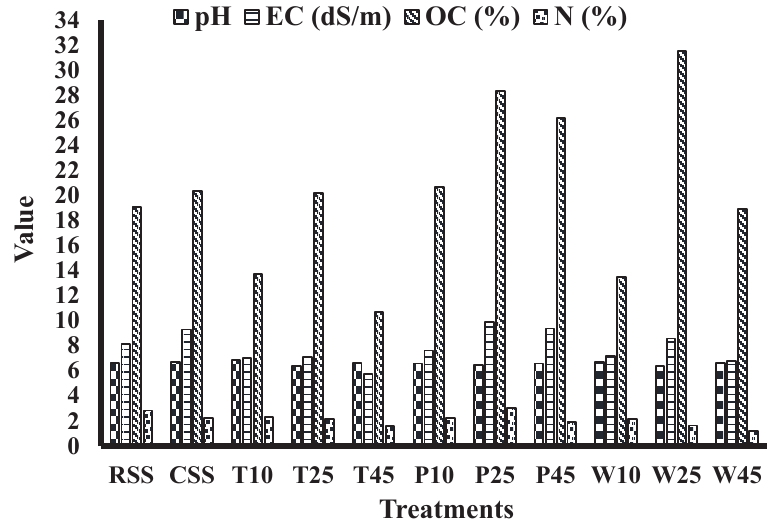
Figure 1: Variation of pH, EC, OC, and total N values in produced SS compost samples as affected by various BAs (Each abbreviation in x-axis is defined in Table